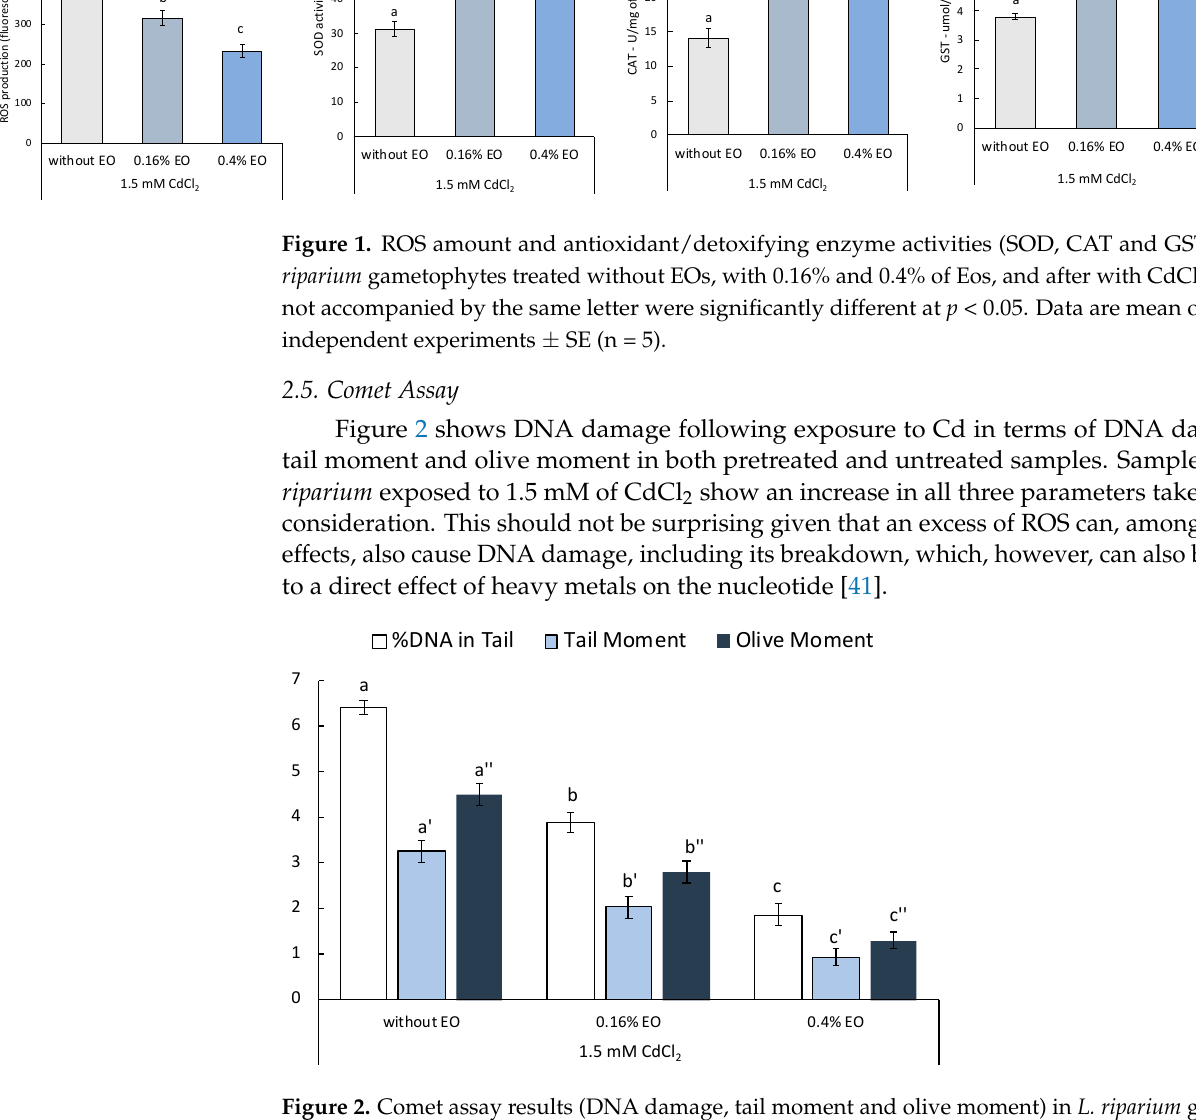
Figure 2. Comet assay results (DNA damage, tail moment and olive moment) in L. riparium gametophytes treated without EOs, 0.16% and 0.4% of EOs, and after with CdCl 2 . Data were presented as mean and standard error and they were analyzed with a paired t -test. Bars not accompanied by the same letter were significantly different at p < 0.05.